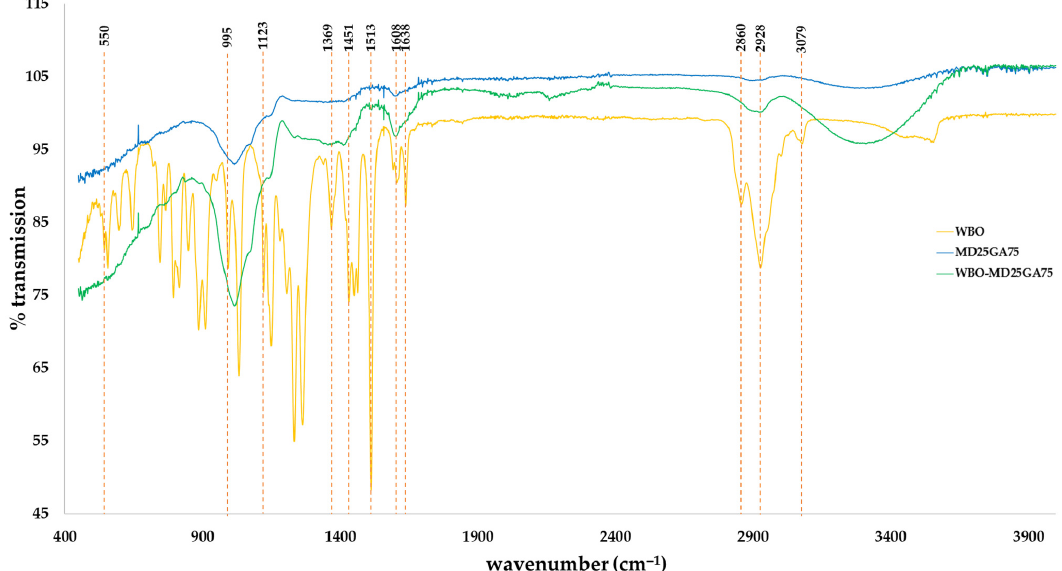
Figure 2. FTIR spectra of white holy basil oil (WBO), the wall material (MD25GA75), and white holy basil oil-loaded product (WBO-MD25GA75).